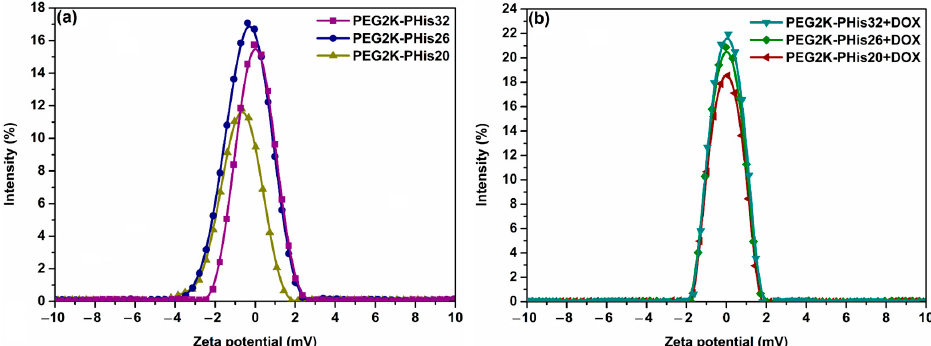
Figure 3. Mean zeta potential distribution curves of the unloaded micelles ( a ) and DOX-loaded micelles ( b ).